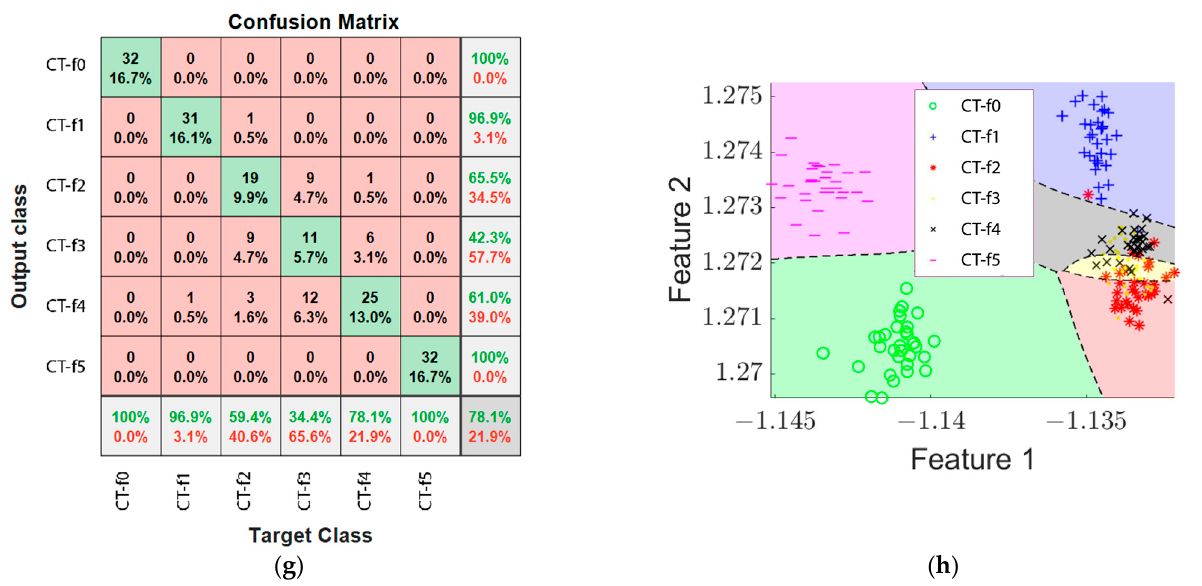
Figure 15. Confusion matrices and classification results obtained for the 0.24 mm/rev tests: ( a ) confusion matrix for image analysis; ( b ) classification of tool wear for image analysis; ( c ) confusion matrix for stray flux analysis; ( d ) classification of tool wear for stray flux analysis; ( e ) confusion matrix for current analysis; ( f ) classification of tool wear for current analysis; ( g ) confusion matrix for image, current and stray flux fusion; ( h ) classification of tool wear for image, current and stray flux fusion.